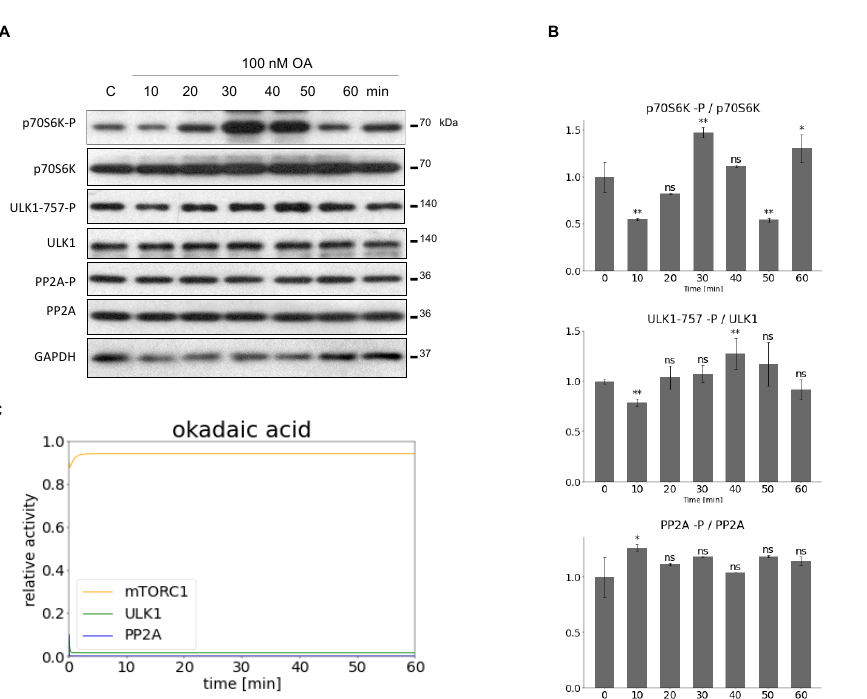
Figure 3. Inhibiting PP2A activity to set the parameters of our minimal model. HEK293T cells were denoted in time after 100 nM OA. ( A ) The markers of ULK1 (ULK1-757-P), PP2A (PP2A-P) and mTORC1 (p70S6K-P) were followed by immunoblotting. GAPDH was used as loading control. ( B ) Densitometry data represent the intensity of ULK1-757-P normalized for total level of ULK1, PP2A- P normalized for total level of PP2AC and p70S6K-P normalized for total level of p70S6K. For each of the experiments, three independent measurements were carried out. Error bars represent standard deviation asterisks indicate statistically significant difference from the control: ns—nonsignificant; *— p < 0.05; **— p < 0.01. ( C ) The computational simulation is determined upon OA treatment